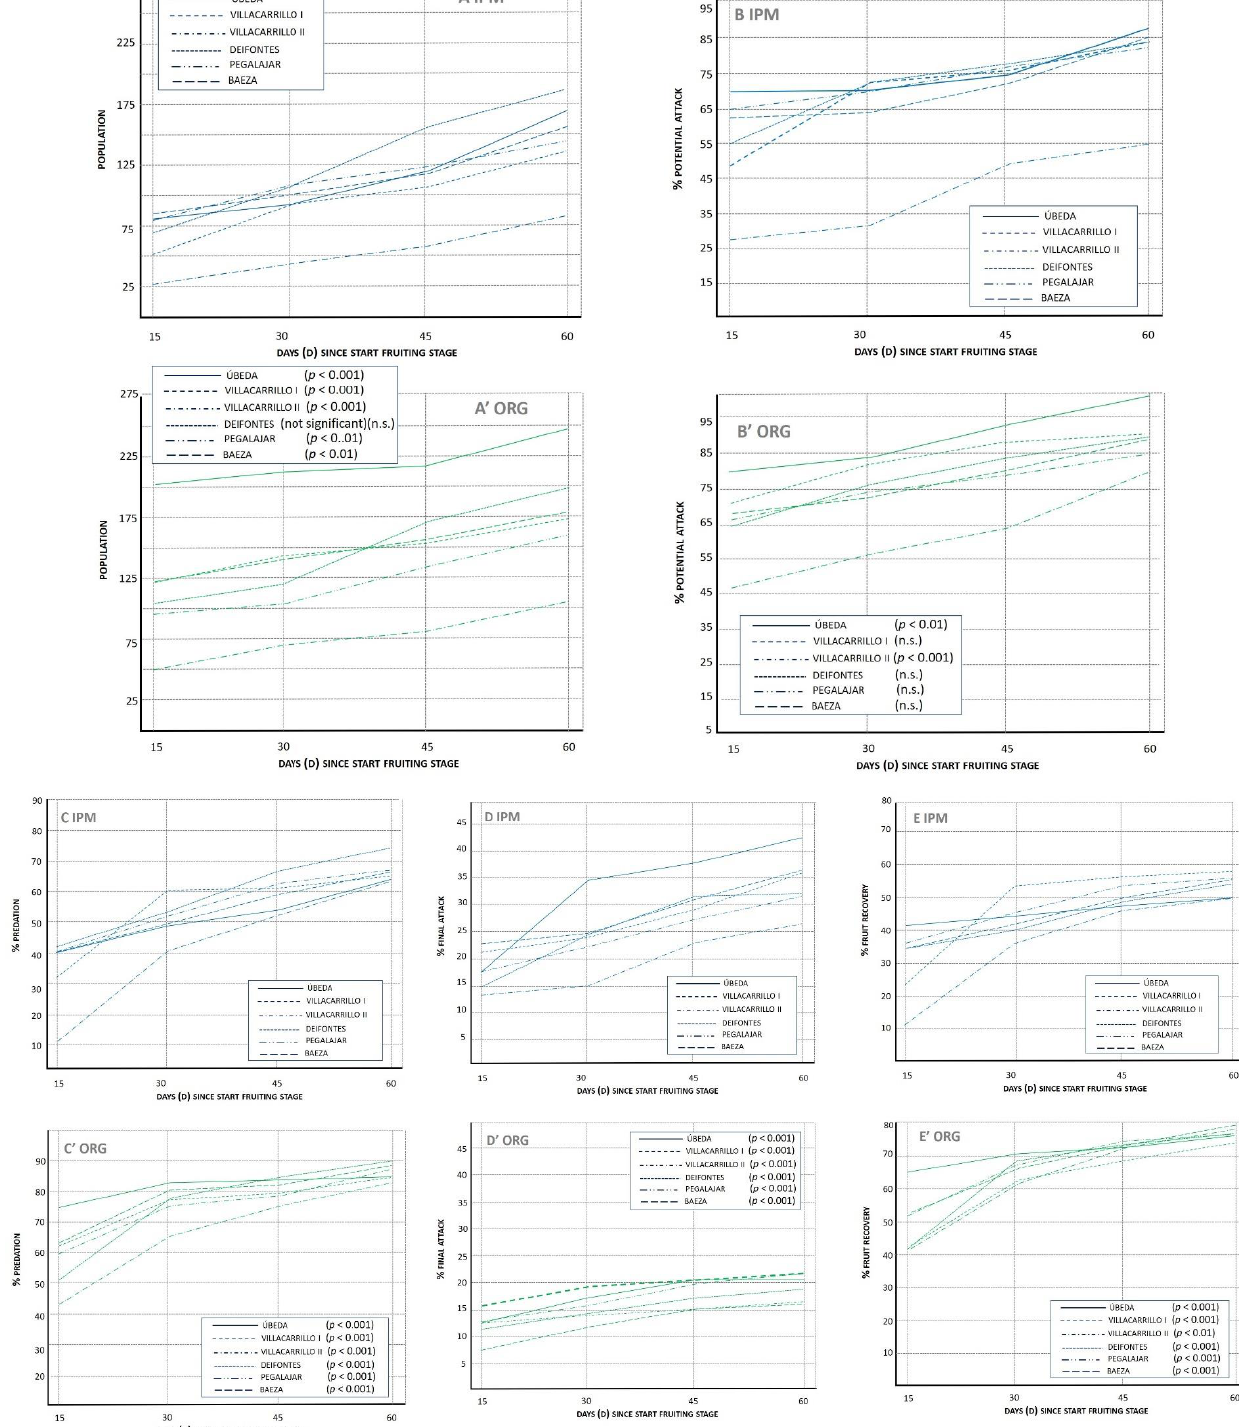
Figure 2. P. oleae attack parameters in the paired plots in southern Spain, corresponding to the two agronomic managements models: IPM ( A – E ) and organic ( A’ – E’ ). Population index (POP, Graphs A , A’ ). Potential Attack (%PA, Graphs B , B’ ); Predation (%PRED, Graphs C , C’ ); Final Attack (%FA, Graphs D , D’ ); % Recovery (%REC, Graphs E , E’ ). The graphs corresponding to the organic olive groves show the results of the analysis of variance (ANOVA) conducted to determine the levels of statistical significance between olive farming systems at the last sampling date.